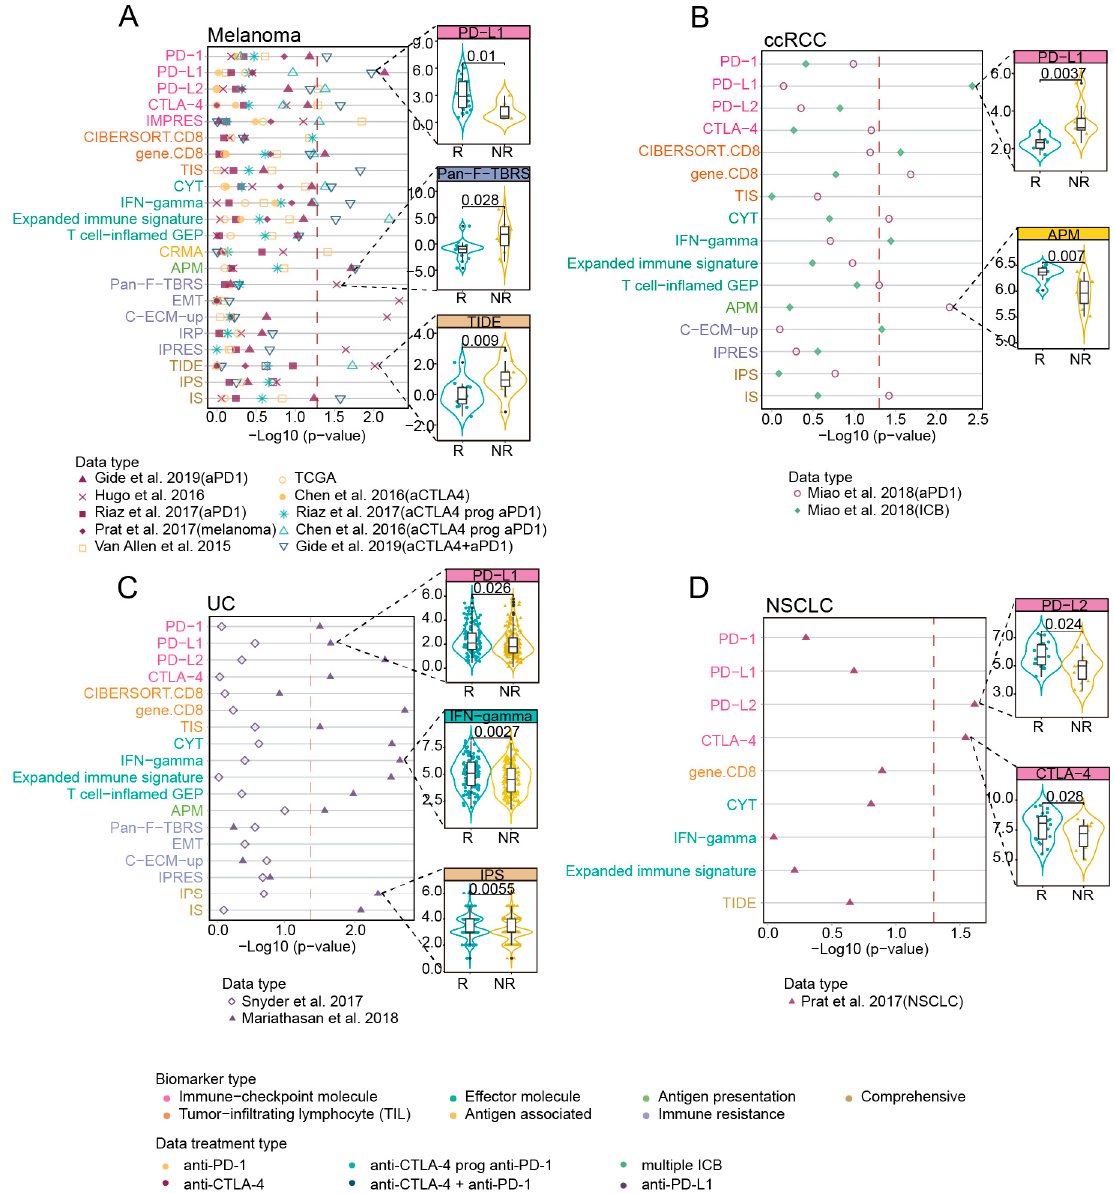
Figure 3. Correlation of biomarkers with clinical response to ICB across multiple datasets with different cancer types. ( A – D ) Left: the two-sided Wilcoxon rank-sum test p value indicating whether biomarkers significantly differentiate between responders versus non-responders (NR) (patients stratification using “PD” strategy) in distinct tumors, red dashed line indicated 0.05 threshold of p value. The color of the dot represented ICB treatment types of each dataset. Magenta denoted anti-PD-1, yellow denoted anti-CTLA-4, light green denoted “anti-PD-1 after progression on prior anti-CTLA-4”, blue represented combined anti-PD-1 and anti-CTLA-4 immunotherapy, grass green represented multiple ICB treatments, and purple represented anti-PD-L1. Right: boxplots showing examples of biomarkers with significant difference (Wilcoxon rank-sum test p < 0.05) between the responding (R) versus non-responding (NR) tumors. Black lines in the box represented upper 75%, median, and lower 25%